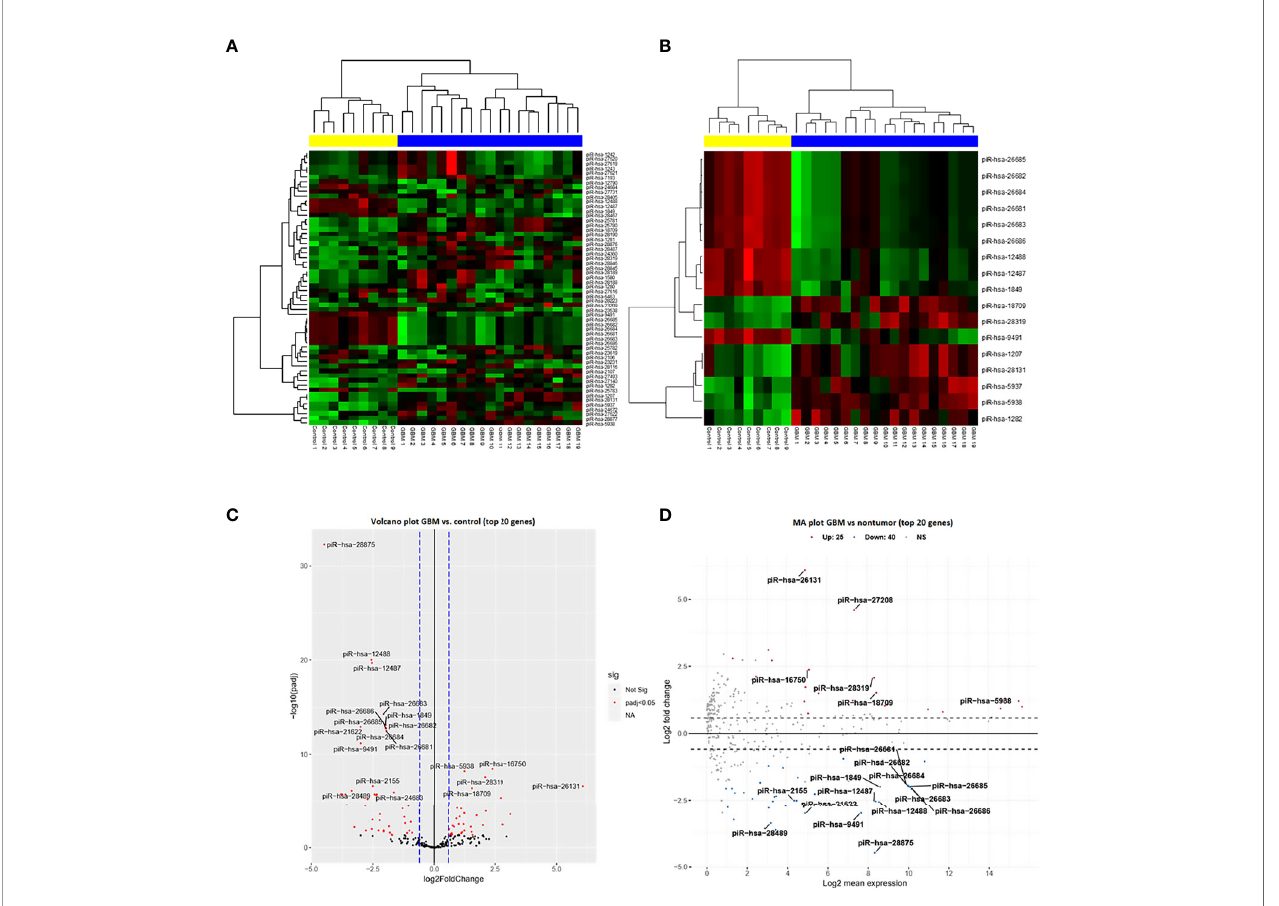
FIGURE 1 | PiRNA expression pro fi ling based on next-generation sequencing data. (A) Clustering analysis with heatmap based on the expression of 58 identi fi ed piRNAs meeting the criteria of more than 50 reads in at least 50% of samples. Samples were divided into a tumor group (blue) and a control group (yellow) with 100% sensitivity and 100% speci fi city. Thirty- fi ve piRNAs were upregulated (red) in glioblastoma and 23 were downregulated (green) in glioblastoma. (B) Clustering analysis of 17 selected differentially expressed piRNAs (adj. p < 0.0001) in glioblastoma compared to non-tumor controls. (C) Volcano plot of the dependency of the log2 adjusted p -value on log2 Fold Change of all analyzed ( n = 58) piRNAs. Red dots represent signi fi cantly dysregulated piRNAs (adj. p < 0.05); 20 genes with the highest results are described by their names. (D) Volcano plot of dependency of the Log2 fold change on Log2 mean expression of all analyzed ( n = 58) piRNAs. Red dots present signi fi cantly dysregulated piRNAs (adj. p < 0.05); 20 genes with the highest results are described by their